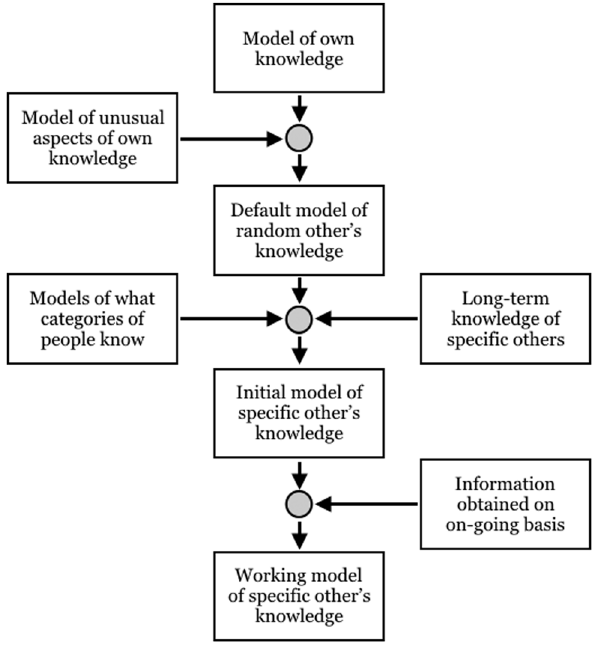
Figure 1: A working model of a speci fi c other ’ s knowledge, adapted from Nickerson ( 1999 )